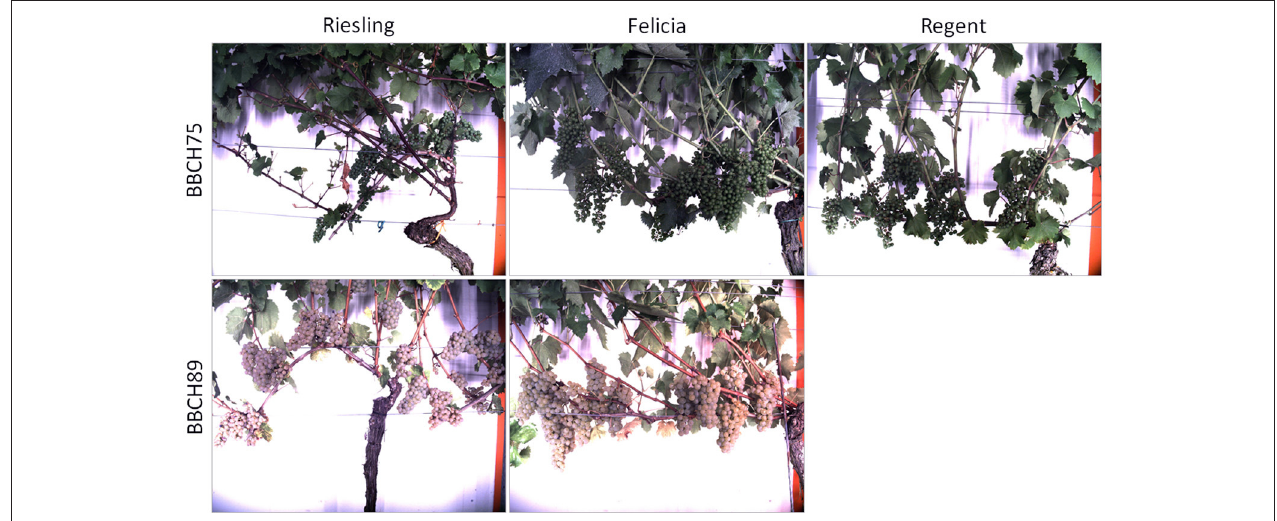
FIGURE 1 | Examples from the dataset consisting of healthy plants without damaged berries, including different varieties and growth stages.